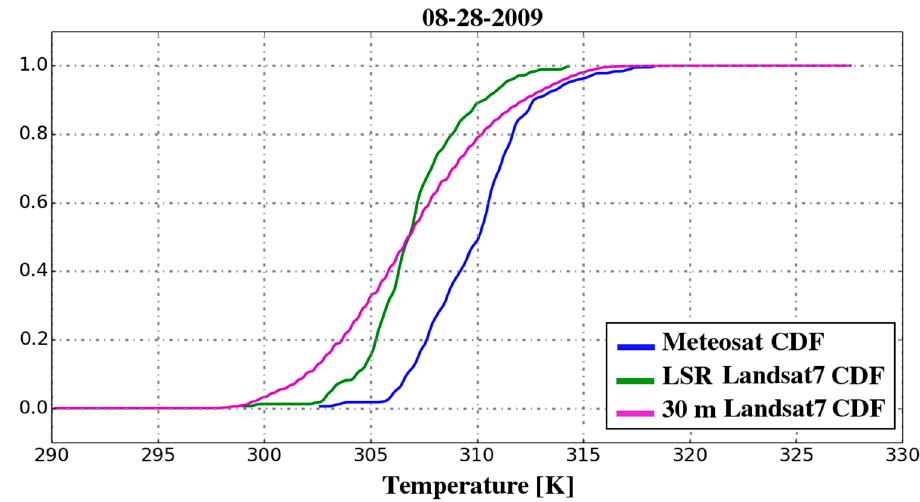
Figure 4. Cumulative distribution function (CDF) calculated for the three images acquired at about the same time by Meteosat (Blue curve) and Landsat 7 upscaled at the same resolution (green curve) and Landsat 7 at full resolution (30 m, pink curve).